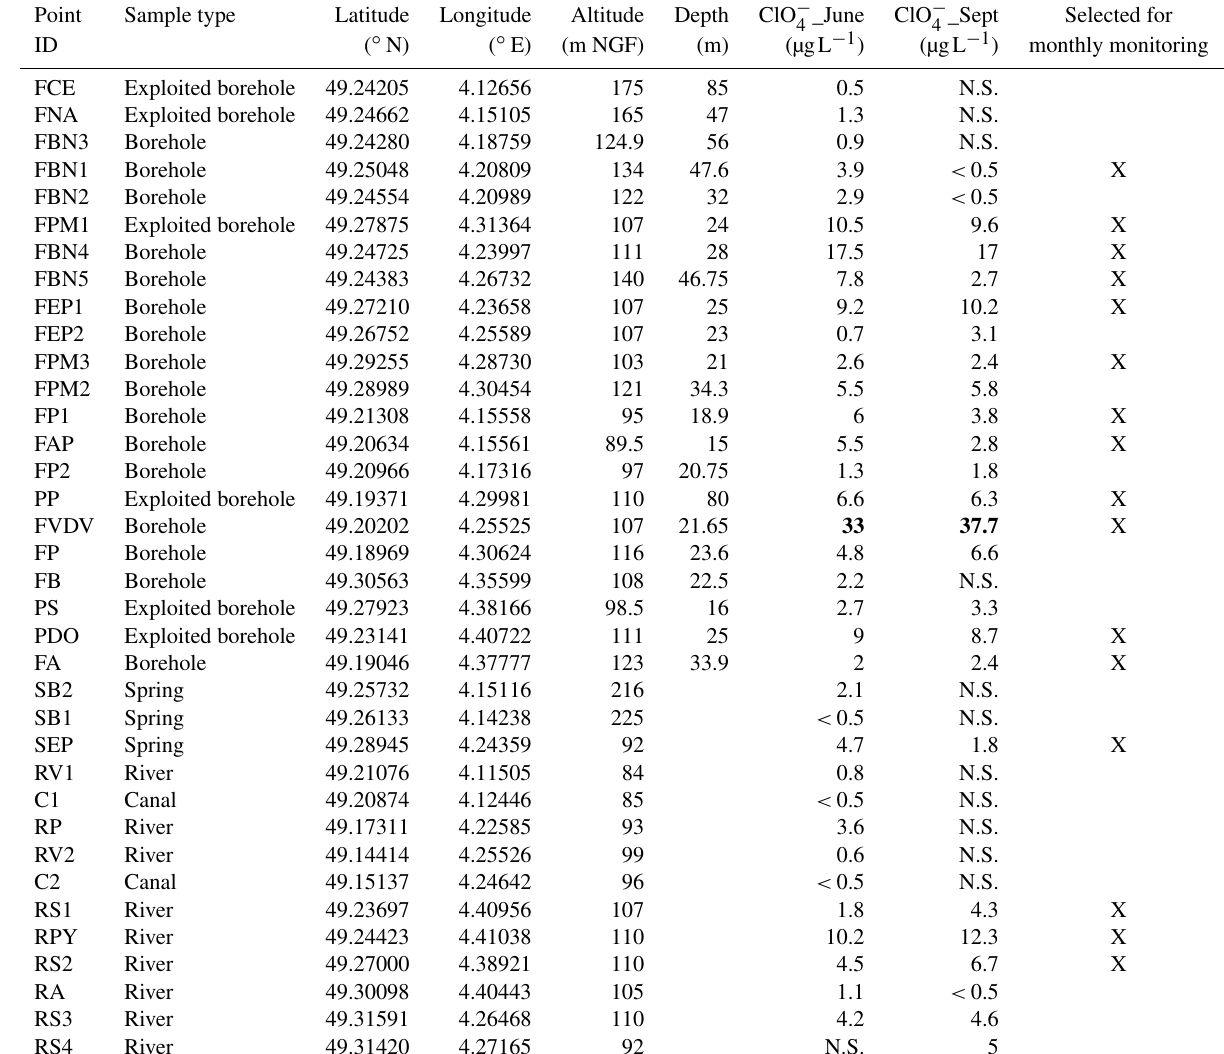
Table 1. Information on sampling locations and perchlorate concentrations. The values in bold are the maximum concentrations of perchlo- rate in June and September. The symbol “X” represents the points selected for monthly